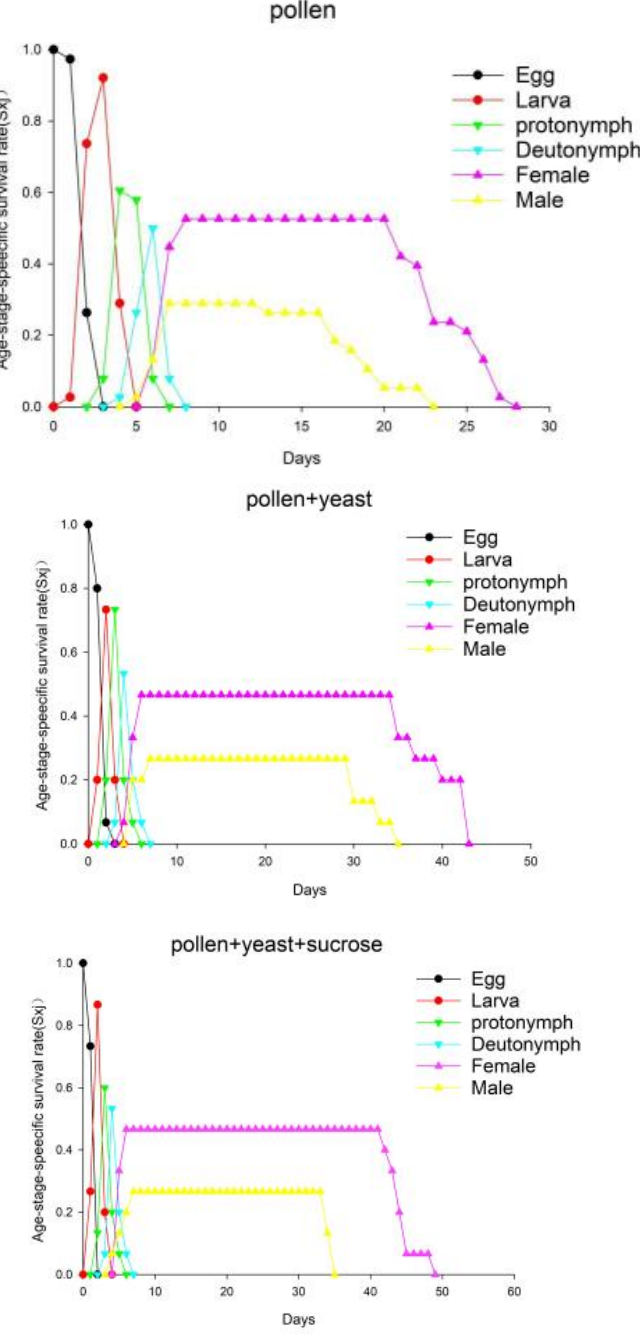
Figure 1. The survival rate of Amblyseius orientalis individuals in the three treatment groups. S xj indicates the probability that a newly laid egg will survive to age x and stage j.